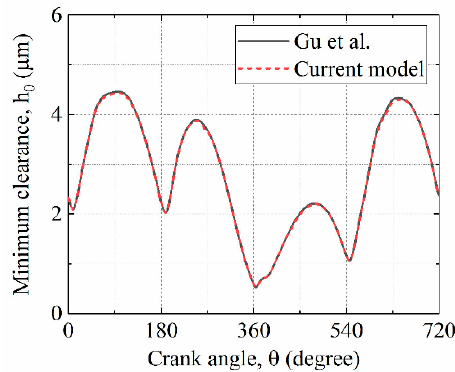
Figure 6. Minimum clearances calculated by the current model and the model of Gu et al. [41].